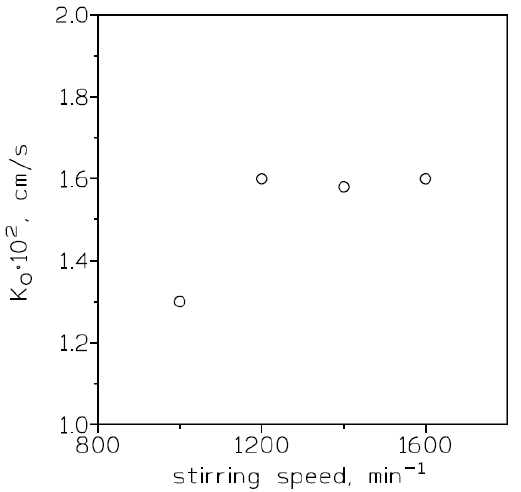
Figure 3. Overall mass transfer coefficients versus stirring speeds (feed phase) for chromium(VI) transport using Cyanex 923 in Solvesso 100 as mobile carrier. Support: